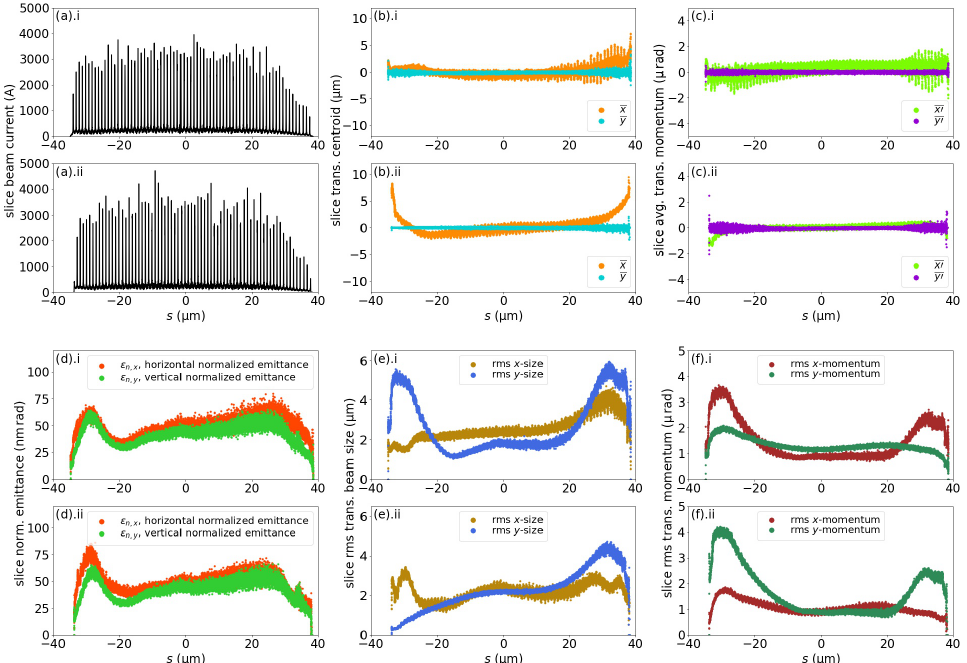
Figure 12. Comparison of the longitudinal distributions of the electron beam properties at the entrance of the X-ray undulator, after the beam traversed lattice 1 ( a.i – f.i ) and lattice 2 ( a.ii – f.ii ). The beams are divided into 20,000 slices with equal lengths, and the beam properties per slice are shown for ( a ) beam currents, ( b ) transverse centroid shifts, ( c ) transverse average momentum shifts, ( d ) normalized transverse emittances, ( e ) rms transverse beam sizes, and ( f ) rms transverse beam momentum